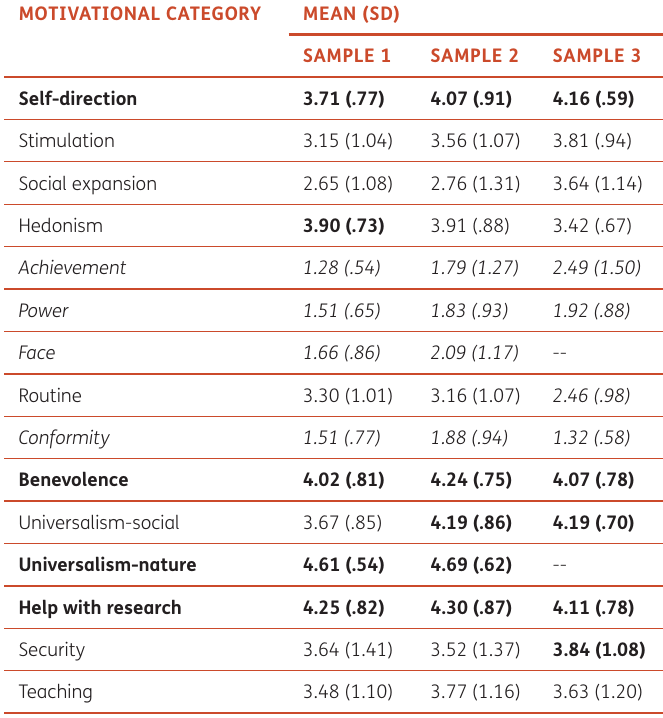
Table 2 Mean scores (SD) of motivational categories for participation in the three CS projects: backyard nature observation (sample 1), bird counting (sample 2), and quality-of-life improvement (sample 3). Each sample’s five top-rated motivational categories are in bold ; the bottom four are in grey italic